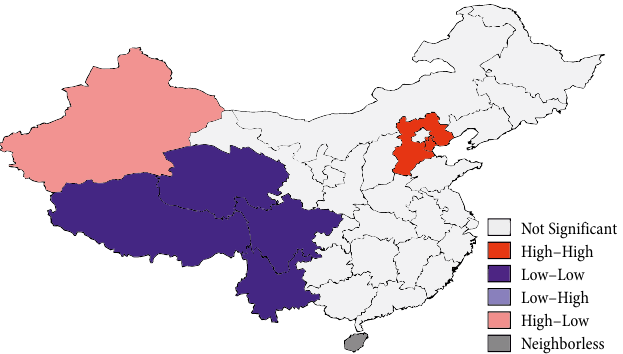
Fig. 2. The Local Moran’s Index of provincial average schooling year during 1996 and 2010